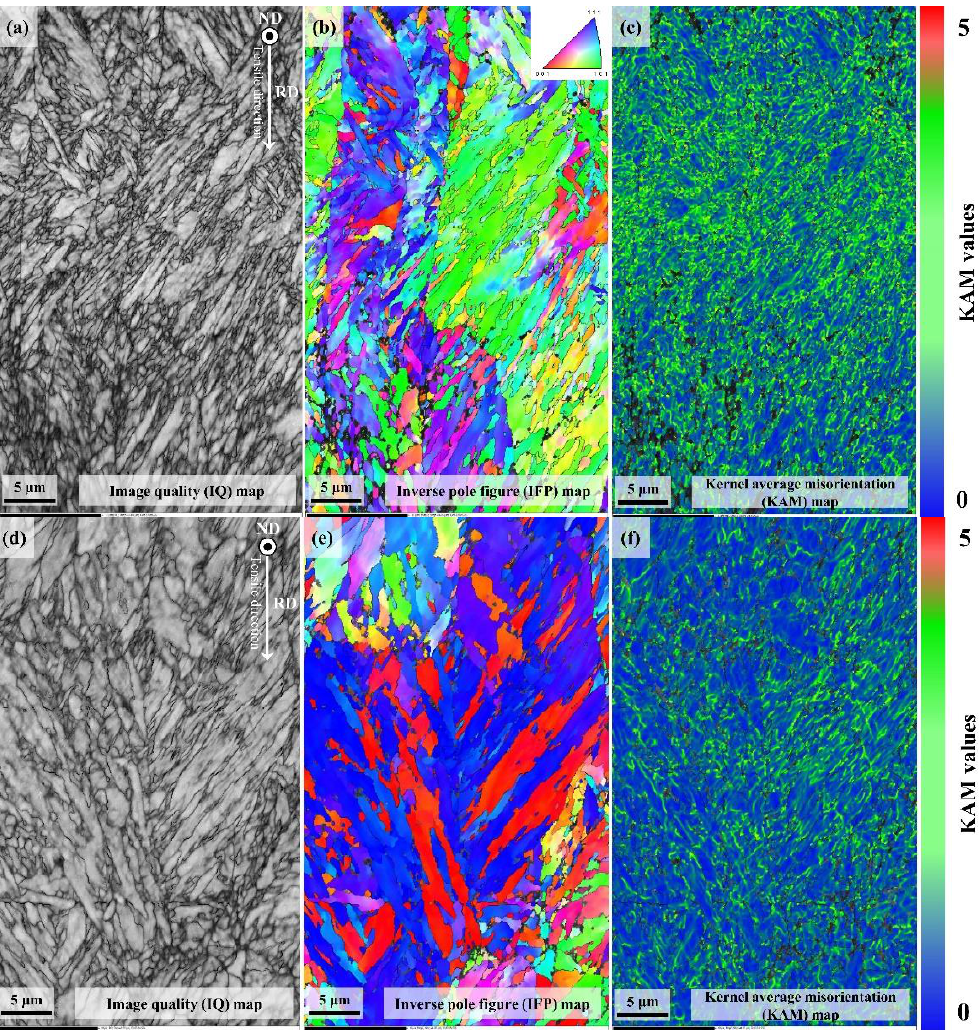
Figure 13. ( a ) IQ map of tensile deformed microstructure; ( b ) IPF map and ( c ) KAM map of alloy A; ( d ) IQ map; ( e ) IPF map and ( f ) KAM map of alloy